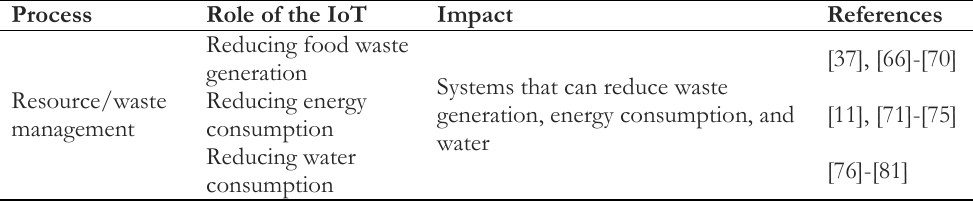
Table 6. Use of the IoT in resource management/waste in the food supply chain.